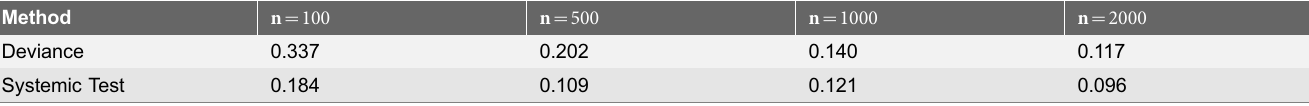
Table 5. Comparison of type I error rates between the deviance test and the systemic